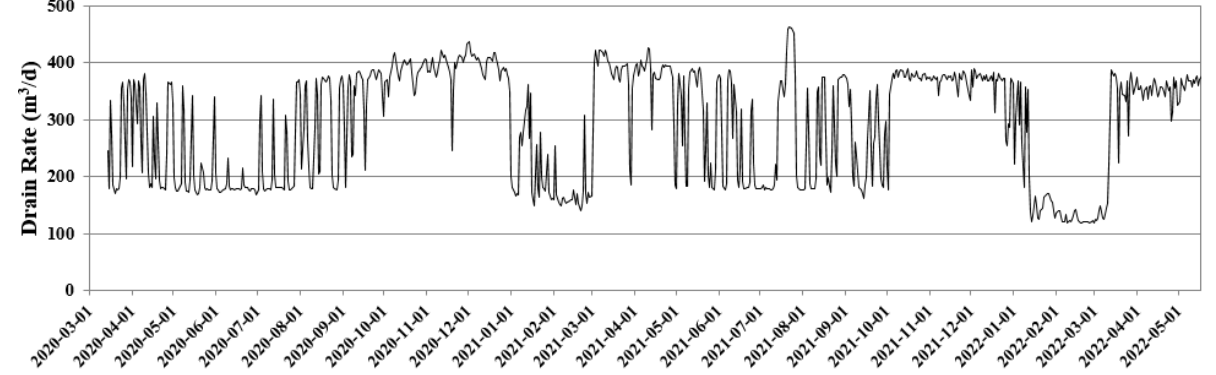
Figure 10. Water drain rates from sand dam.